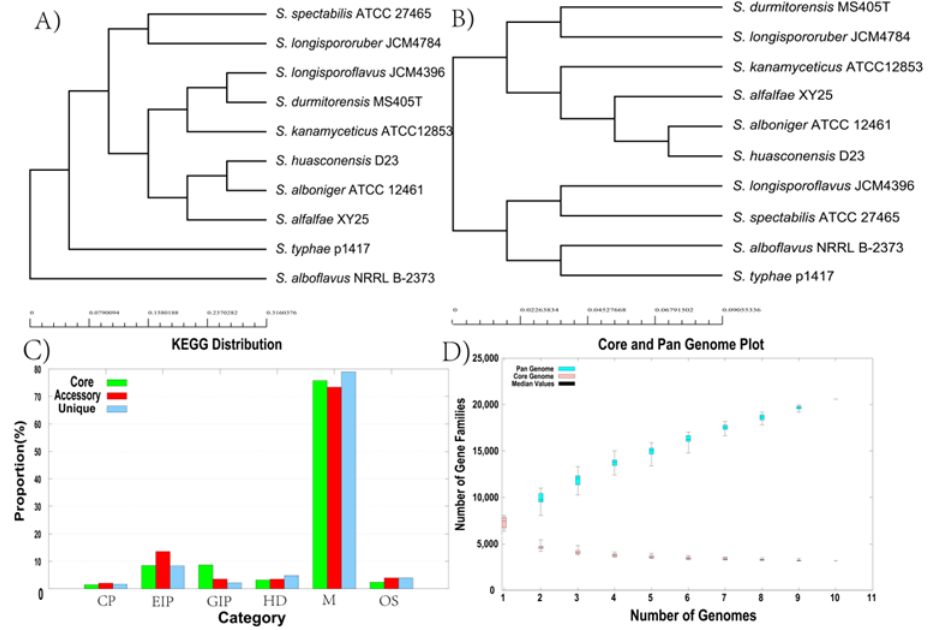
Figure 7. Pan-genomic analysis of S. huasconensis D23 and its evolutionarily related strains. ( A ) Neighbor-joining tree derived from 3165 pan orthologous proteins. ( B ) Neighbor-joining tree